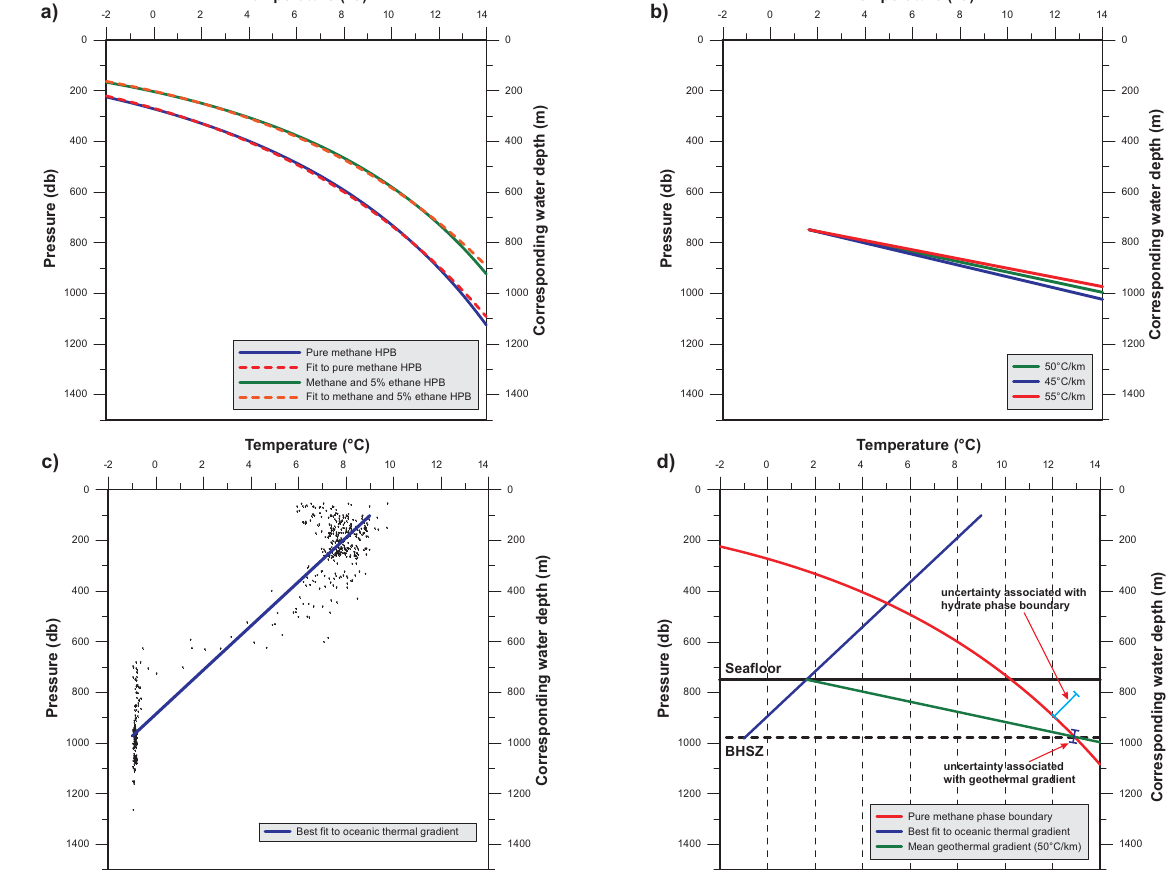
Figure 3. Modeled HSZ extent (red areas = hydrate can form) compared to the bottom-simulating reflection (stippled yellow line) as observed on 2D line JMF97-215. This particular model is based on a pure methane system with saline pore water, a high geothermal gradient and an average oceanic thermal